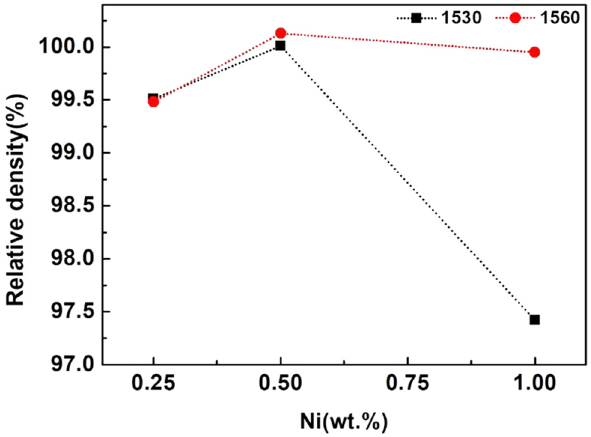
Figure 7: WC – Ni composite ceramics